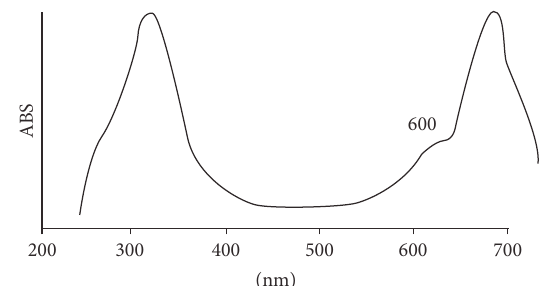
Figure 5: UV-Vis spectra of nano- [ Fe III ( Pc )( SCN )] 𝑛 .